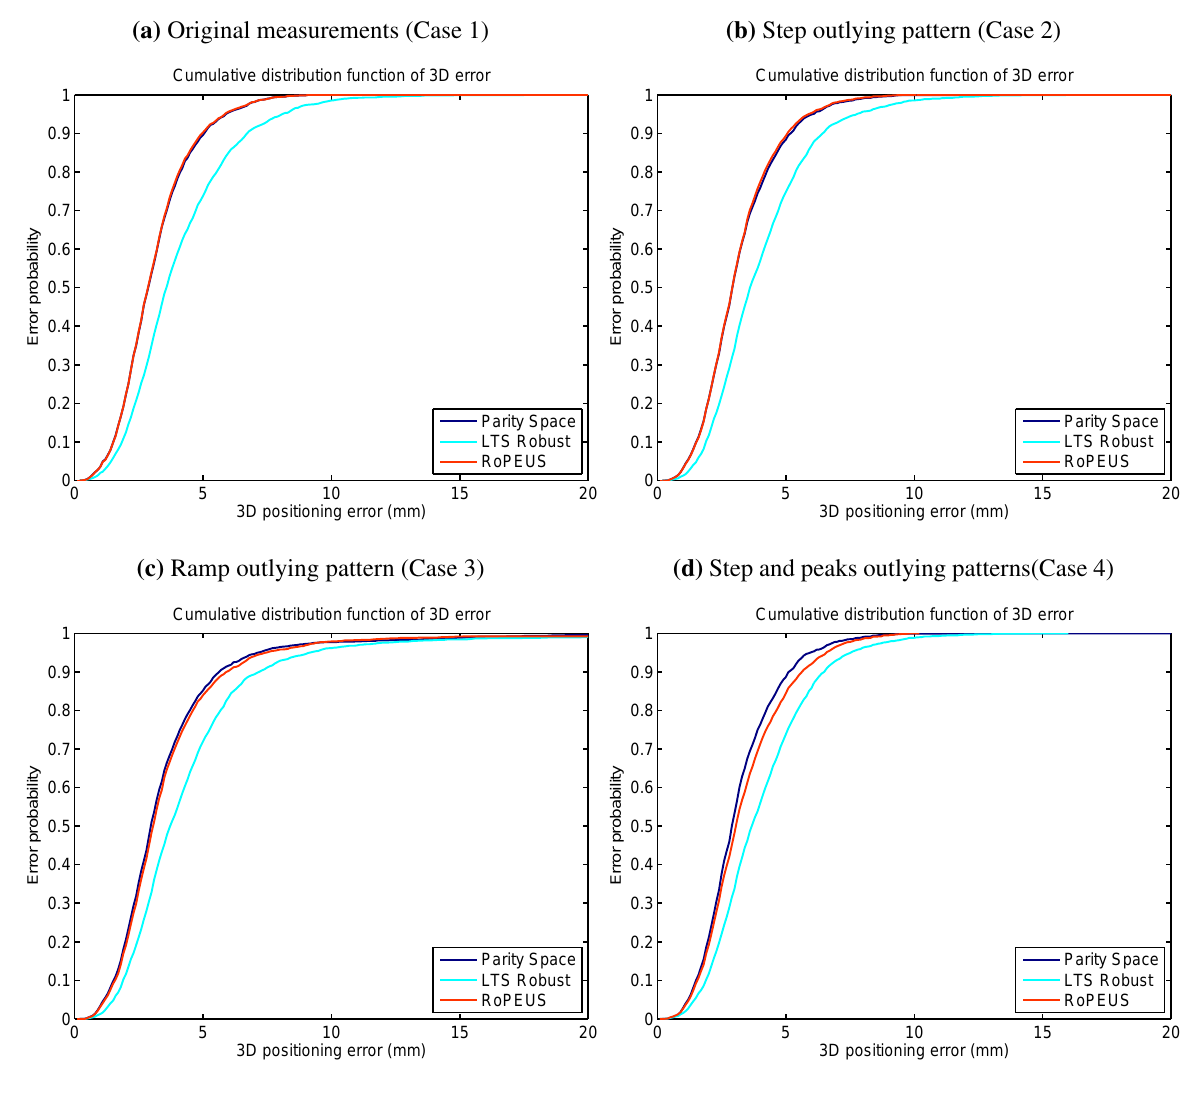
Figure 4. Cumulative distribution function obtained when applying the PS and RoPEUS algorithms to the four cases studied (see Table